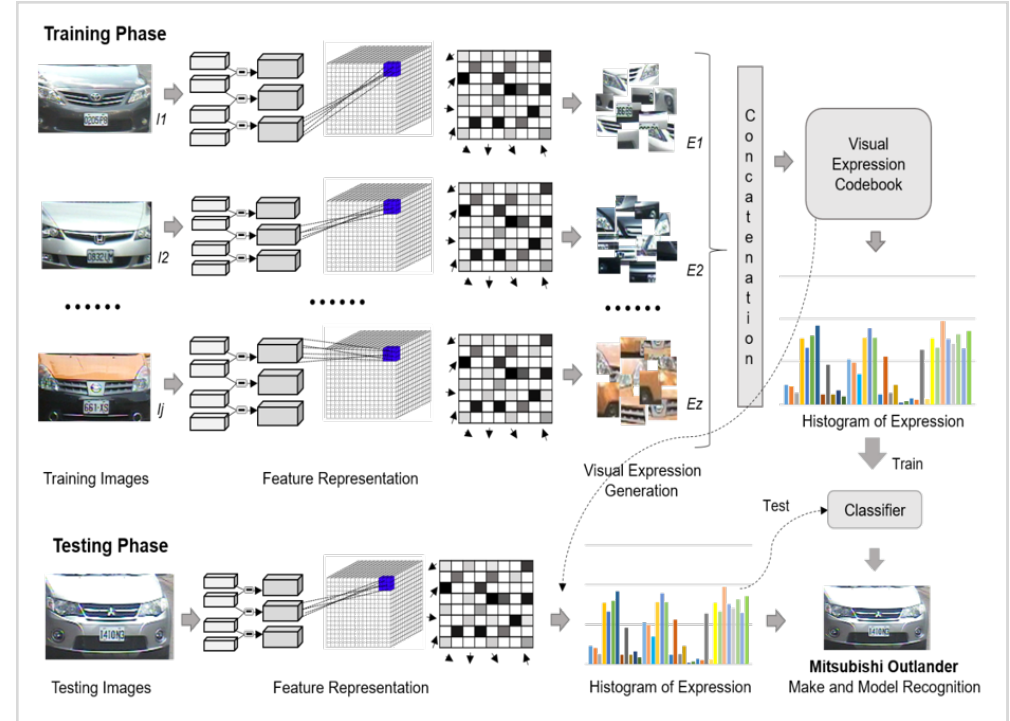
Figure 4. Bag of expressions-based framework for vehicle make and model recognition